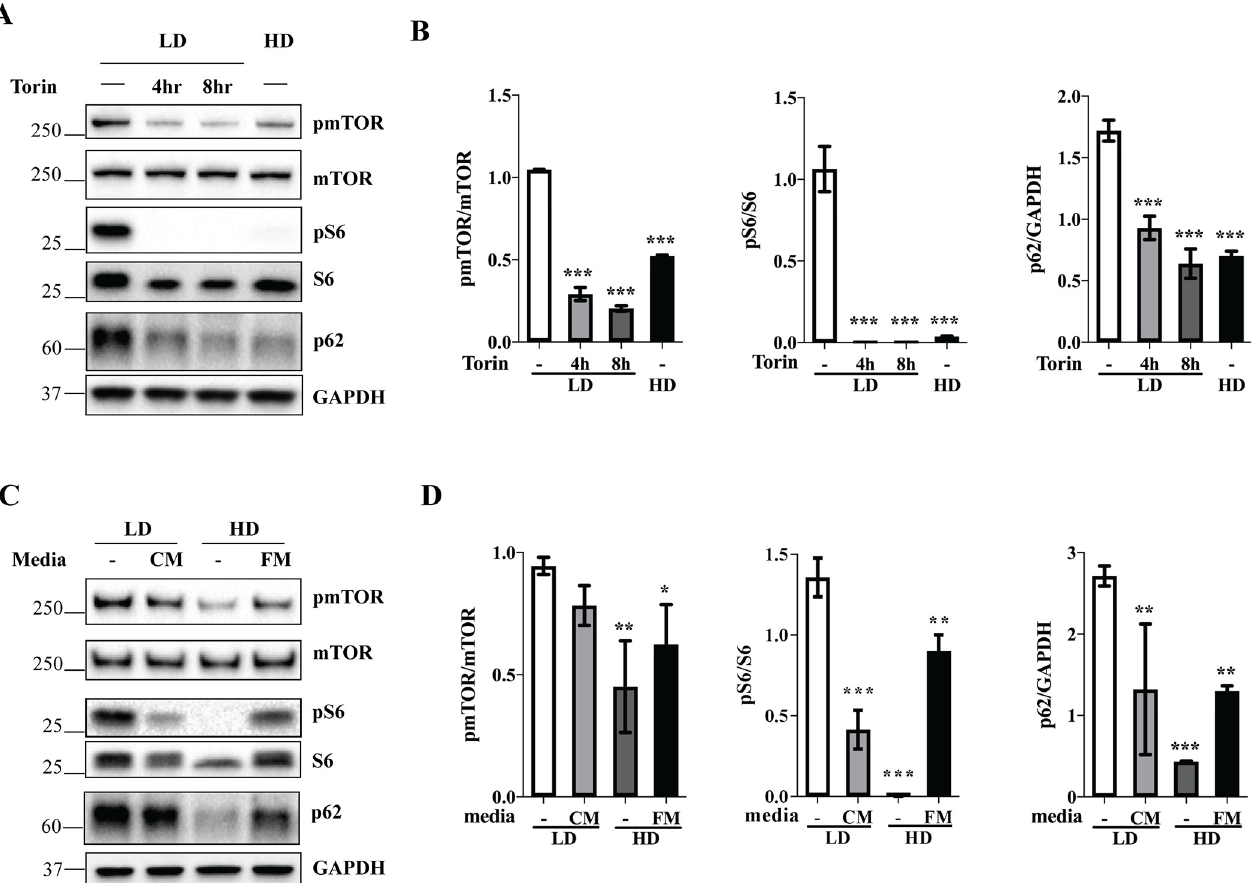
Fig 2. Media conditioning and cell crowding regulate autophagy through inactivation of mTOR signaling pathway. (A) HEK 293FT cells were plated at low density (LD, 50K) or high density (HD, 1200K) and treated with vehicle (-) or 330 nM Torin for the indicated period of time before cell lysis. (C) Cells were plated at low or high density and incubated during the entire experiment in intact media (-), conditioned media (CM), or in the media with continuously maintained freshness (FM), as indicated. (A,C) Cell lysates were analyzed by Western blotting using indicated antibodies. (B,D) Western blot images were quantified and the values normalized to GAPDH unless indicated otherwise. N = 3; Bar graph data are mean ± SD. � p < 0.05, �� p < 0.01, ��� p < 0.001, relative to LD-.